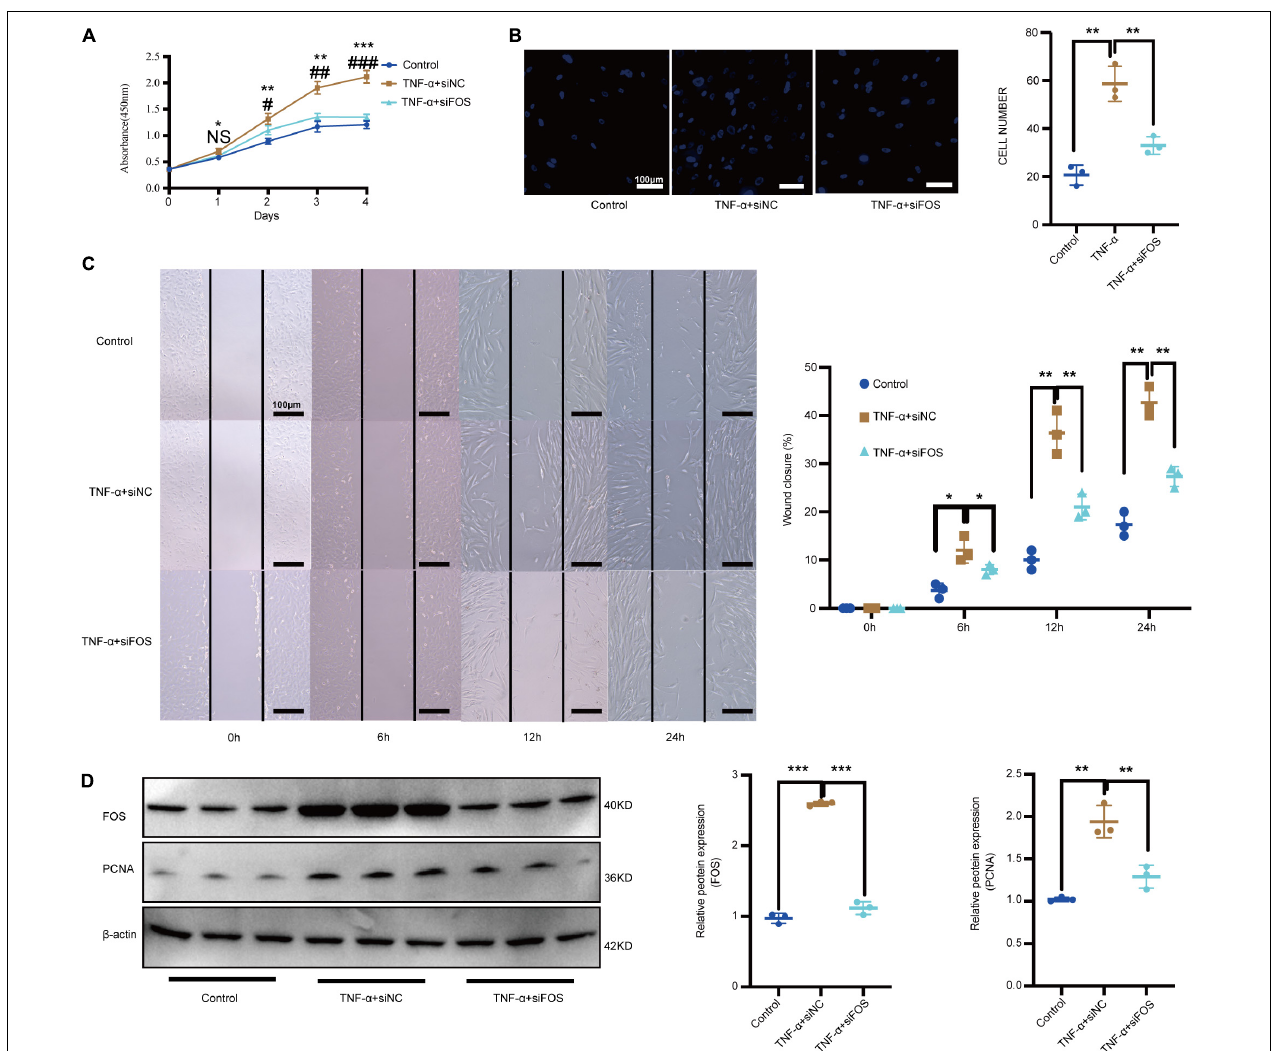
FIGURE 7 | TNF- α promotes the proliferation and migration of normal VSMCs via increased FOS expression. Proliferation and migration of normal VSMCs as measured by (A) CCK-8 assay, (B) transwell assay, and (C) scratch-wound assay after treatment with TNF- α or TNF- α treatment (50 ng/mL, 24 h) plus preincubation with FOS-siRNA (24 h). (D) Western blot analysis of PCNA and FOS in normal VSMCs after treatment with TNF- α or TNF- α treatment (50 ng/mL, 24 h) plus preincubation with FOS-siRNA (24 h). N = 3, results are expressed as the mean ± SD. *represent TNF- α + siNC VS Control; # represent TNF- α + siFOS VS TNF- α + siNC * p < 0.05, ** p < 0.01, and *** p < 0.001. NS represent no significantly change, # p < 0.05, ## p < 0.01, and ### p < 0.001. Data were analyzed using one-way